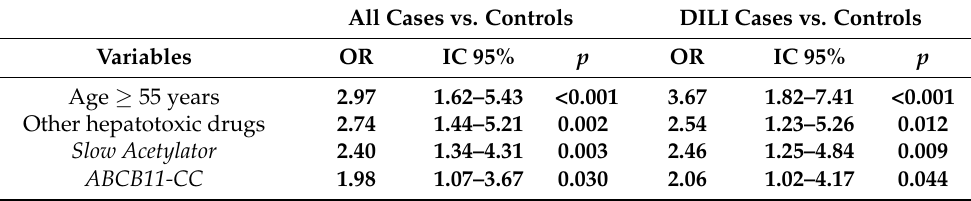
Table 5. Results of refined logistic multivariate analysis for all cases and DILI. All Cases vs. Controls DILI Cases vs.